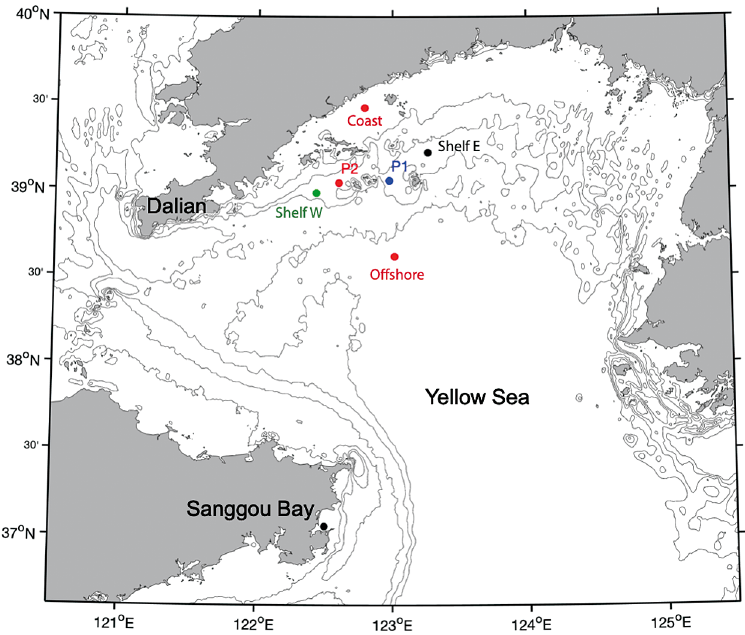
Fig. 1. The northern part of the Yellow Sea. Lines represent bathymetry every 10 m between 20 and 50 m depths. Colored dots: time series locations; P1: location of the current observations; P2: location of more detailed analysis of the bottom temperature variations. Zhangzidao Island is between P1 and